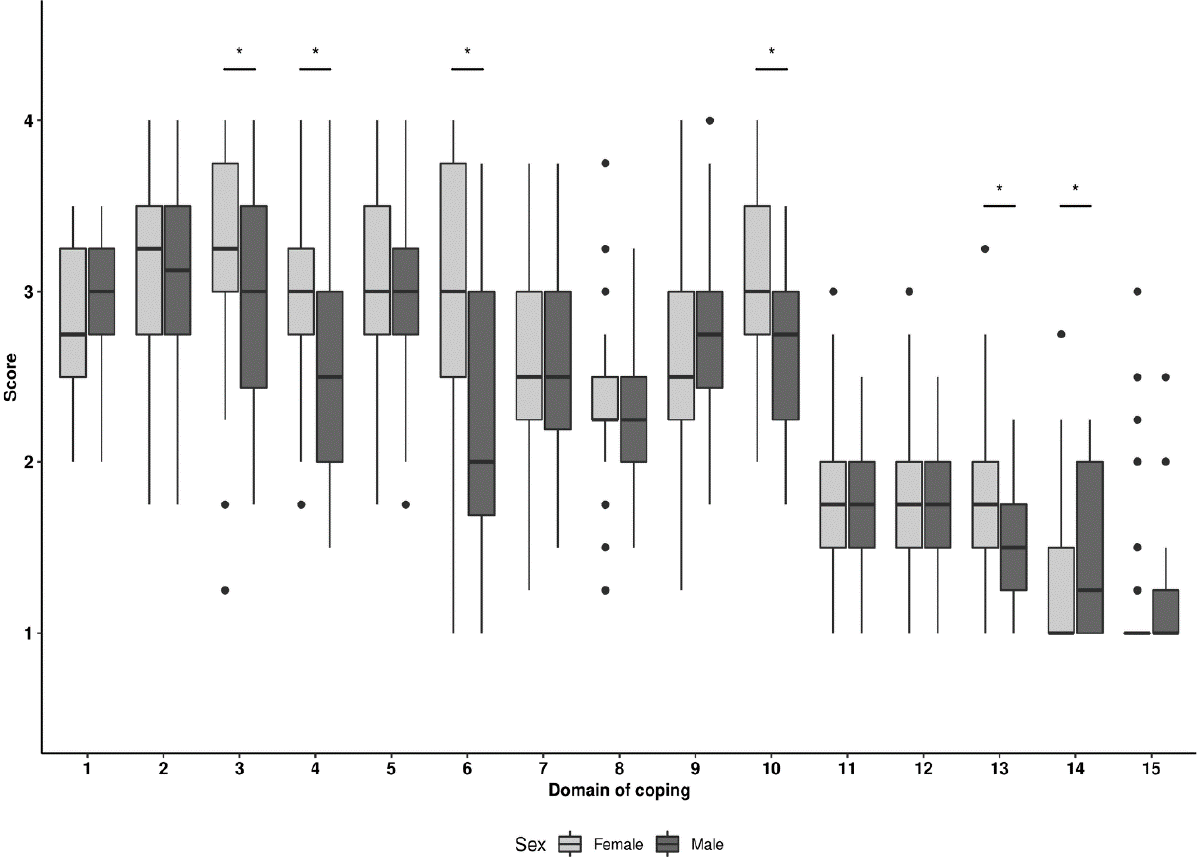
Figure 1. Parents’ stress coping strategies by sex. Note: * —statistical significance Parents of children who were diagnosed 6 or less than 6 months before presented a statistically significantly higher score for the strategy of Suppression of competing activities , as compared to parents whose children were diagnosed more than 6 months before ( p = 0.007). No relations were found between the period of time since the diagnosis of the dis- ease and other strategies of coping with stress—Table S1. Numerous relationships were found characterized by varying strength and direction between particular strategies of coping with stress in the examined group, which led, among others, to identifying mutual positive correlations between all pairs of strategies such as: Seeking for instrumental support, Seeking for emotional support, Turning to religion and Focus on and venting of emotion . On the other hand, the strategies such as Planning, Seeking for emotional social support and Suppression of competing activities were negatively correlated with Mental disengagement, Substance use and Sense of humor . Negative correlations were detected also between the strategies: Substance use and Seeking for instrumental social sup- port; Substance use and Turning to religion; as well as Mental disengagement and Turning to religion . The details of Spearman’s rank correlation analysis between particular stress cop- ing strategies among parents are presented in Table S2. 3.4. Assessment of the Relationship between the Examined Emotional States (HADS) and the Level of Perceived Stress (PSS-10) A positive correlation of average strength was observed between the level of stress in women and the severity of depression, anxiety and aggression. In the male group, no correlations were found between the level of stress and HADS results in any category. A positive correlation between the level of stress in the examined group of parents and the intensity of examined emotions was observed regardless of the period of time since the diagnosis of the child’s disease—Table 5.